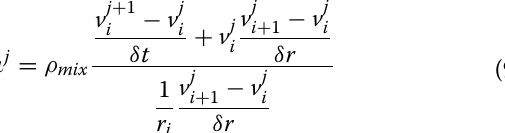
r ( t ) and the computed incremental viscosity µ − µ 0 throughout the normalized time r 0